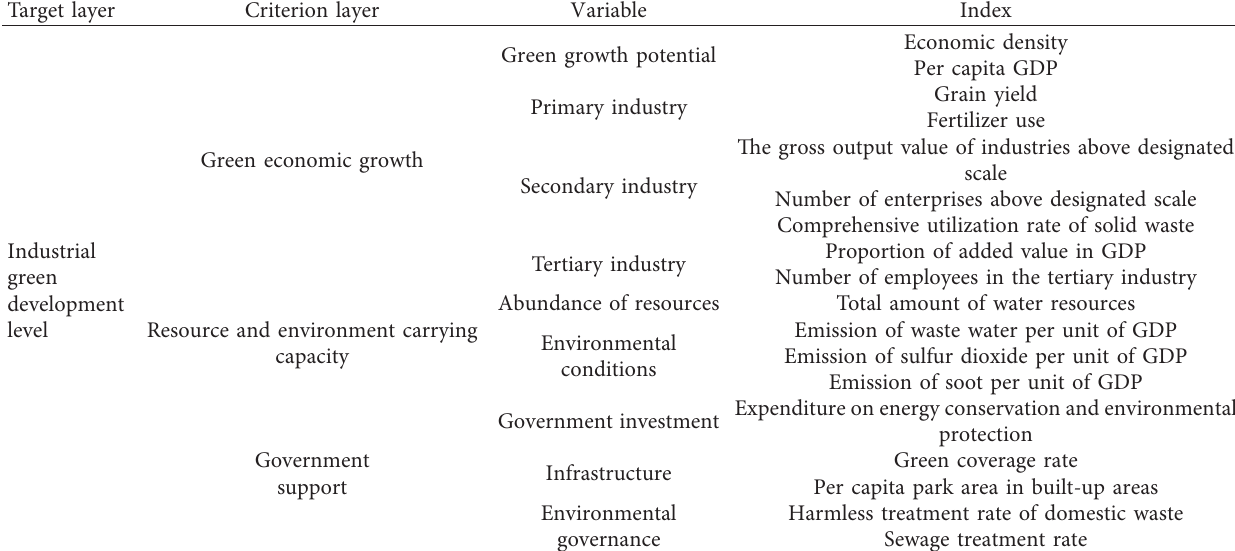
Table 1: IGD evaluation index system of cities in